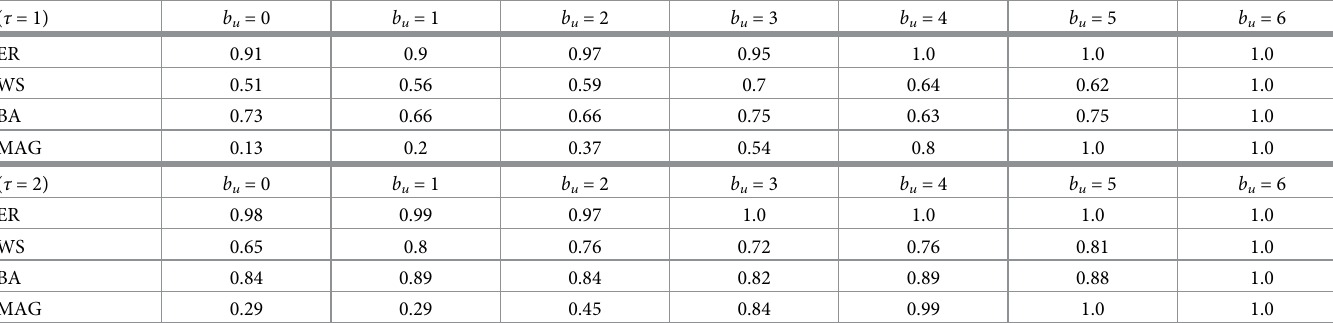
Table 4. Probabilities of agents with belief b u having a strongly contagious DCC path to it from an institutional agent.